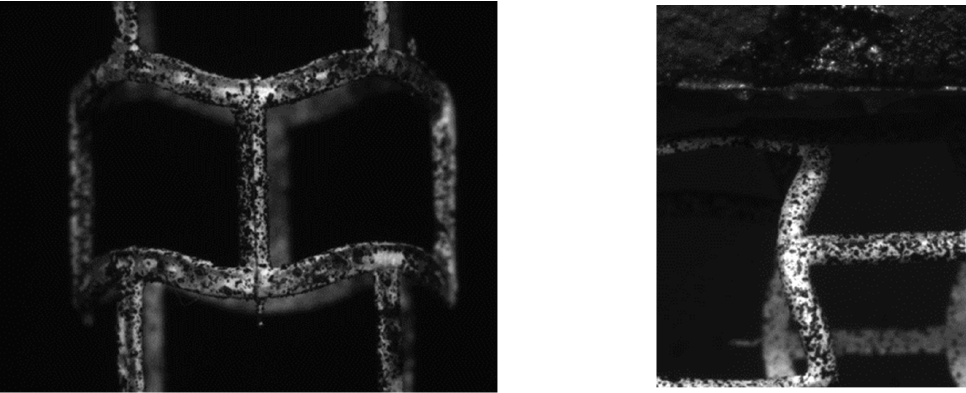
Figure 15. Stent model covered with speckle pattern .